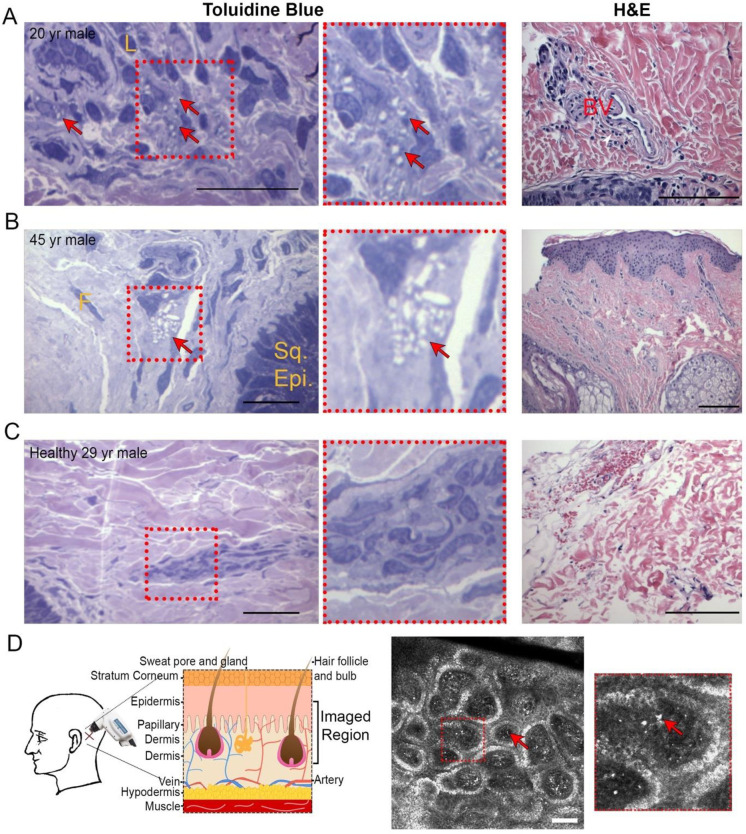
Skin biopsies and intradermal confocal imaging highlight crystals in cystinosis patients.A-C, Skin punch biopsies taken from 1–2 cm behind the mastoid region of the right ear of two cystinosis patients (A-B) and a healthy control (C). Skin biopsy samples were sectioned at 1 μm and then stained with Toluidine Blue to detect cystine crystals and H&E for structural evaluation. Arrows indicate crystals. Crystal counting and morphological measurements were conducted by a clinical pathologist. Scale bar toluidine blue = 50 μm. Scale bar H&E = 100 μm. White arrowhead indicate perivascular chronic inflammatory cells in the upper dermis (A). L = lymphocyte, F = fibroblast nucleus, Sq. Epi. = squamous cell epithelium, BV = blood vessel. D, Intradermal imaging methodology and sample patient image. Using a handheld RCM device, a 78 slice Zstack with step size of 2.8 μm was taken behind the left ear beginning within the epidermis. A representative single slice with arrows indicating crystals is shown, while complete patient and control Zstacks are provided in S1 and S2 Videos. Scale bar = 100 μm.